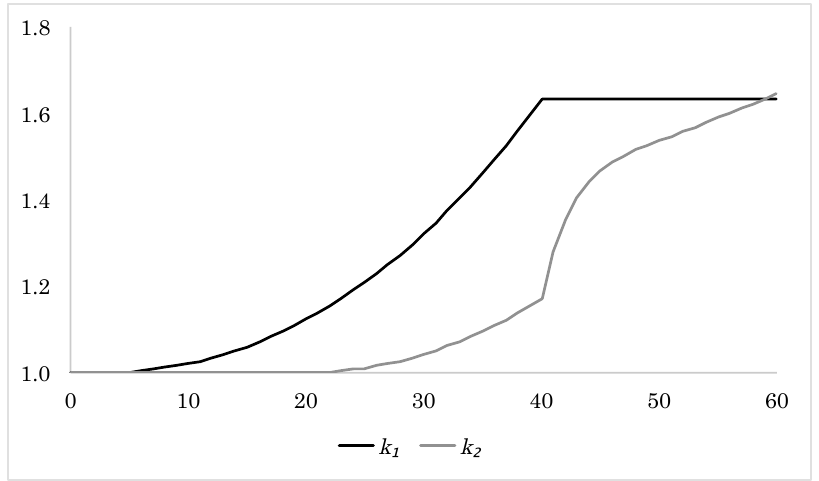
Figure 7. Approximated expected upscaling factors k